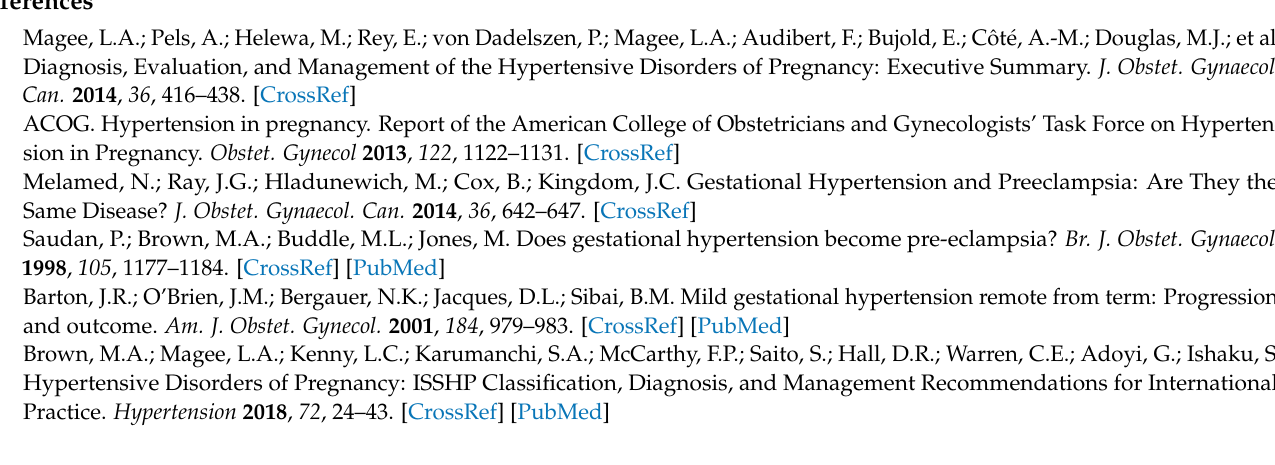
the plasma; Table S1: TMT labelling scheme; Table S2: Peptide spectral matches (PSMs) from plasma shotgun proteomics; Table S3: Raw protein quantification from plasma proteomics; Table S4: Normal- ized proteins from plasma proteomics; S5: Peptide spectral matches (PSMs) from platelet shotgun proteomics; Table S6: Raw protein quantification from platelet proteomics; Table S7: Normalized proteins from platelet proteomics; Table S8: Plasma